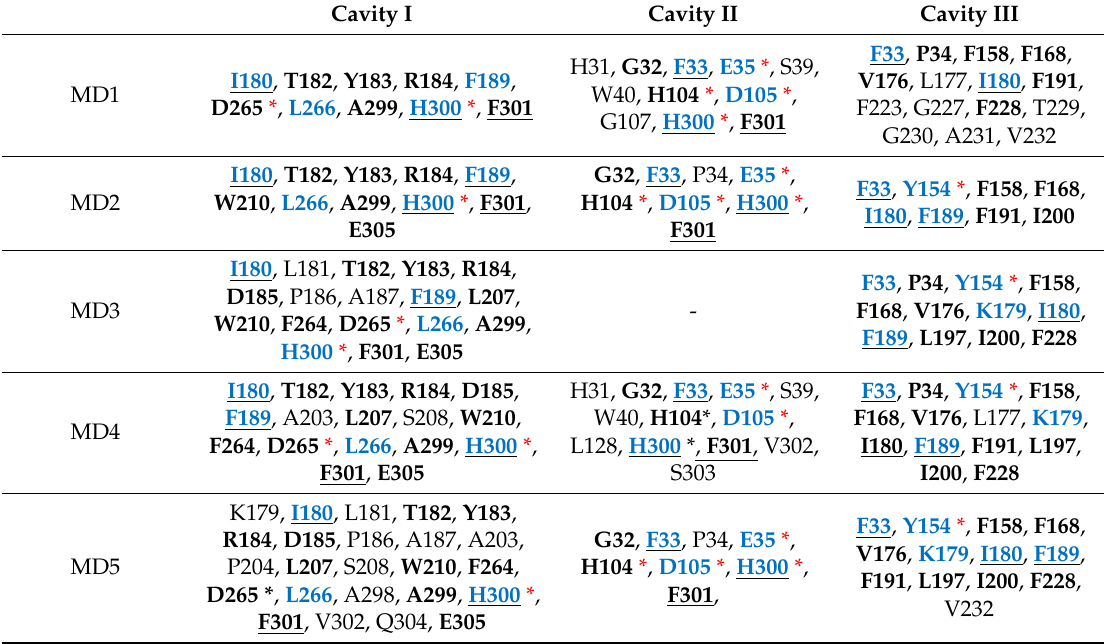
Table 1. Amino acids making up the walls of cavities detected in particular MD simulations. Residues detected in three or more simulations in bold, residues which made up the wall of two cavities are underlined, residues reported as catalytic marked with red star, residues reported in the literature as having mutated in blue. Cavity I Cavity II Cavity III H31, G32 , F33 , E35 *, S39, I180 , T182 , Y183 , R184 , F189 , MD1 W40, H104 *, D105 D265 *, L266 , A299 , H300 *, F301